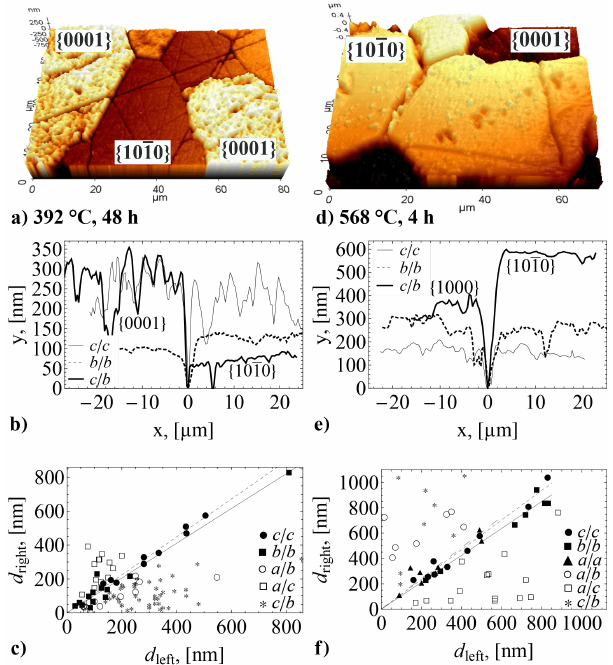
Figure 5. Orientation dependence of height difference between grains after annealing at 392 ◦ C for 48h (a–c) and at 568 ◦ C for 4h (d–f) . (a) and (d) AFM image with ( 0001 ) and (cid:0) 10 ¯ 10 (cid:1) surfaces, (b) and (e) profile normal to grain boundary, x/x describes the surface orientation of neighboring grains where a = (cid:0) 11 ¯ 20 (cid:1) , b = (cid:0) 10 ¯ 10 (cid:1) , and c = ( 0001 ) , (c) relation between groove depth of left and right groove sides and orientation. Differences in groove depth, i.e., step height, are most pronounced for neighboring grains with different